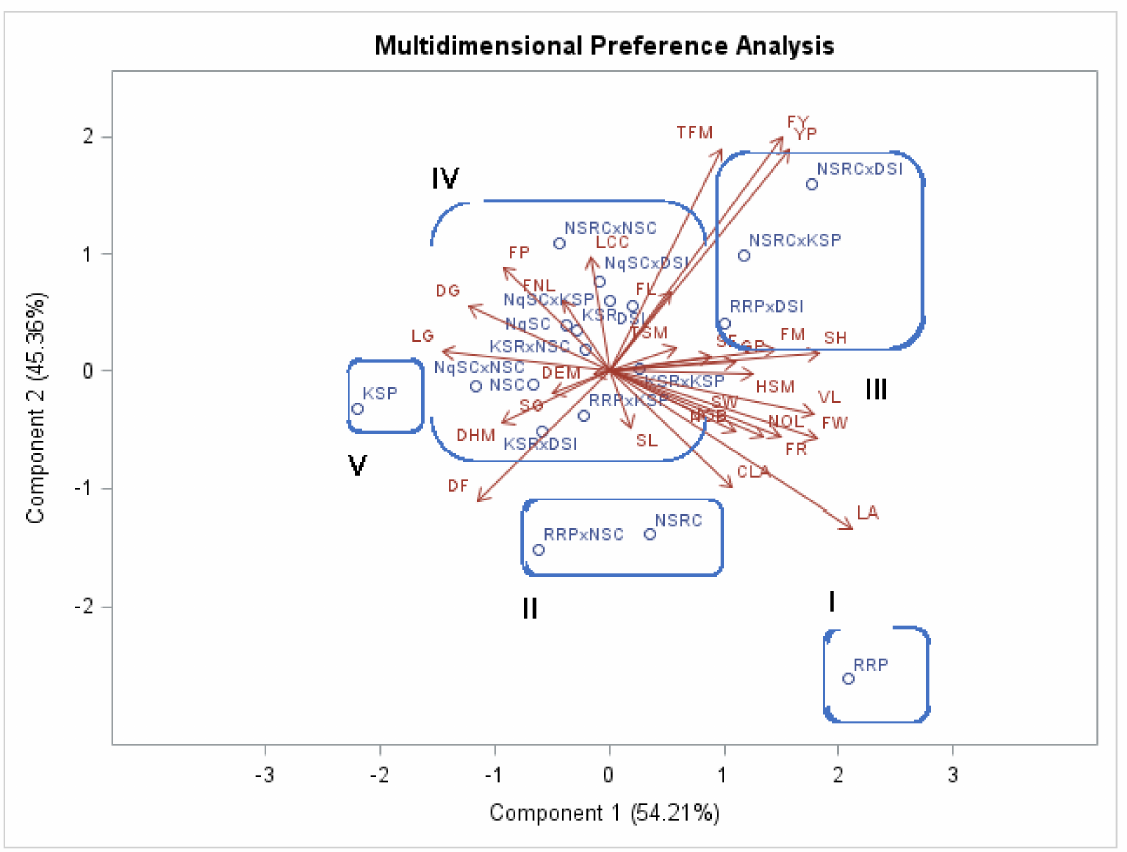
Figure 4. Biplot of Lagenaria siceraria genotypes and agronomic traits. Genotypes and agronomic traits (variables) are described in Tables 2 and 3 and Table 4,